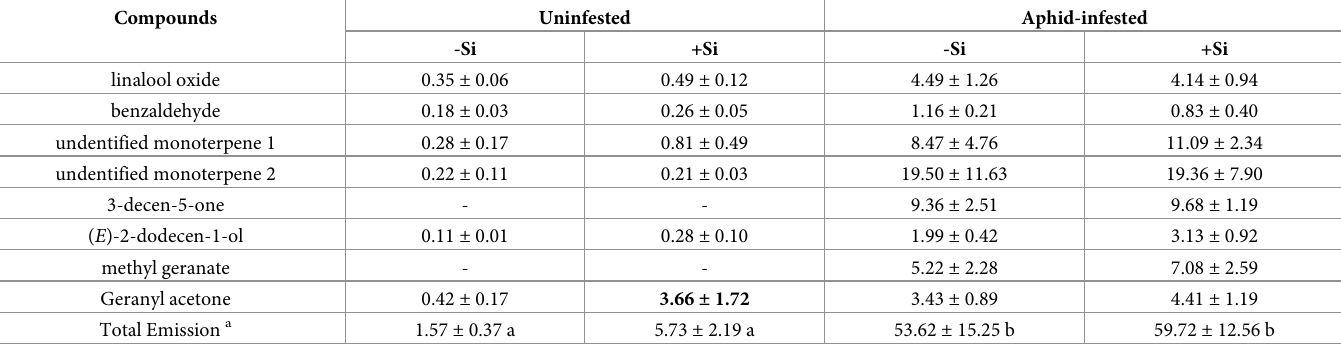
Fig 2. Effect of silicon supplementation on the olfactory response of Lysiphlebus testaceipes to wheat volatiles. Olfactory response of the aphid parasitoid Lysiphlebus testaceipes to volatile emissions from Si-supplemented (+Si) and non-Si supplemented (-Si) uninfested (-aphid) and aphid-infested (+aphid) wheat plants, in the Y-tube olfactometer. The olfactory response of parasitoid females to the treatments were first tested against the clean air (air). Treatments that were attractive were contrasted among themselves. � indicates significant difference at 5% according to chi-square test. �� indicates significant difference at 1% according to chi-square test. https://doi.org/10.1371/journal.pone.0231005.g002 profiles emitted by -Si and +Si uninfested wheat plants revealed that only a single compound, the terpene geranyl acetone, was found at higher amounts in +Si plant volatile emissions. Mol- ecules of the geranyl group potentially function as analogs of ( E )-beta-farnesene (EBF), a com- mon molecule of aphid alarm pheromone that is also shared by R . padi [53], because of their affinity to the same odorant-binding protein [54, 55]. Although far more studies investigated the activity of geranyl acetate to aphids [55–57], repellency of geranyl acetone to the green peach aphid Myzus persicae (Sulzer) (Hemiptera: Aphididae) has been recently demonstrated Table 1. Ratio of compounds (mean ± SE) emitted by silicon-supplemented (+Si) and non-silicon supplemented (Si-) uninfested and aphid-infested wheat plants. Relative amounts were estimated based on the peak area of the internal standard. Bold value indicates significant elevation in relative amount of a compound compared to the control treatment (-Si uninfested wheat plant) according to